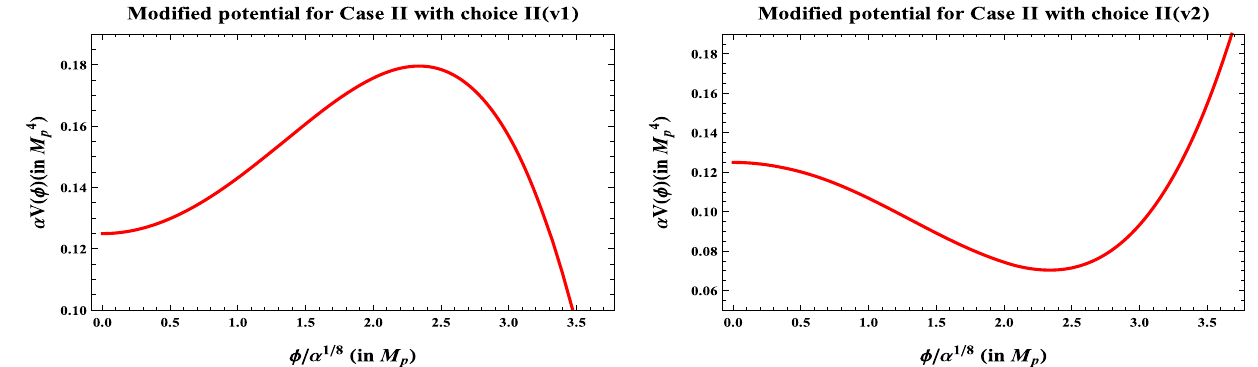
(b) Choice I ( v2 ) : Modified potential from superstring the- ory with λ > 0.